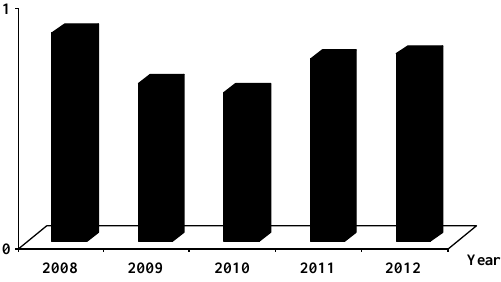
Figure 4. Correlation coefficients between abundance of adult wheat thrips and air temperature. Ovipositions of wheat thrips were found in crops of winter and spring wheat, winter triticale, and winter and spring barley. Phytophage larvae were noted in the ears of winter and spring wheat, triticale, and winter barley, with the exception of spring barley. In the period under study, egg laying began in the first ten days of June, first on winter wheat and then on spring wheat. In the ears of winter wheat, the number of adults varied from 0.2 (SE = ±0.0022) ind./ear to 7.4 (SE = ±0.083) ind./ear; in the ears of spring wheat, from 0.3 (SE = ±0.0034) ind./ear to 2.8 (SE = ±0.031) ind./ear (Figure 5 ).